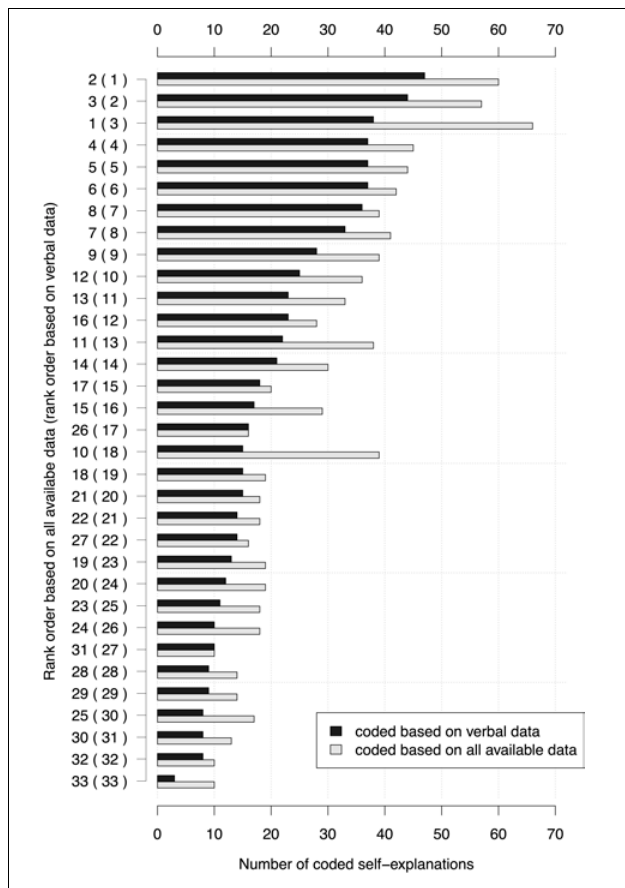
FIGURE 6 | Results of coding self-explanations with different data bases. The black bars depict the number of coded self-explanations based on verbal data. The light gray bars depict the number of coded-self-explanations based on verbal, written and non-verbal data. Bars are ordered according to the numbers of self-explanations coded based on verbal data (numbers in parentheses). In comparison, the order according to the numbers of self-explanations coded based on verbal, written and non-verbal data is